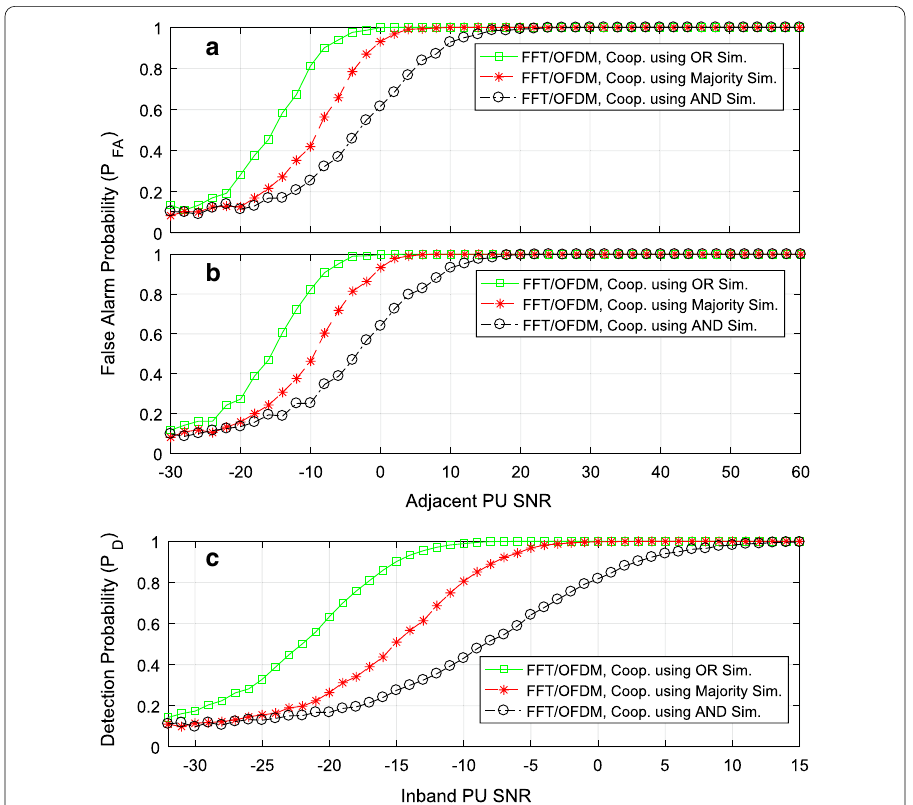
Fig. 5 Comparison of cooperative false alarm and detection probabilities between FFT-based SED for three different linear fusion rules under Indoor channel and log-normal fading ( σ = 9dB ), time record length of N t = 91 , and M 8 sensing stations. a P FA with linear PA. b P FA with nonlinear PA. c P D for inband =